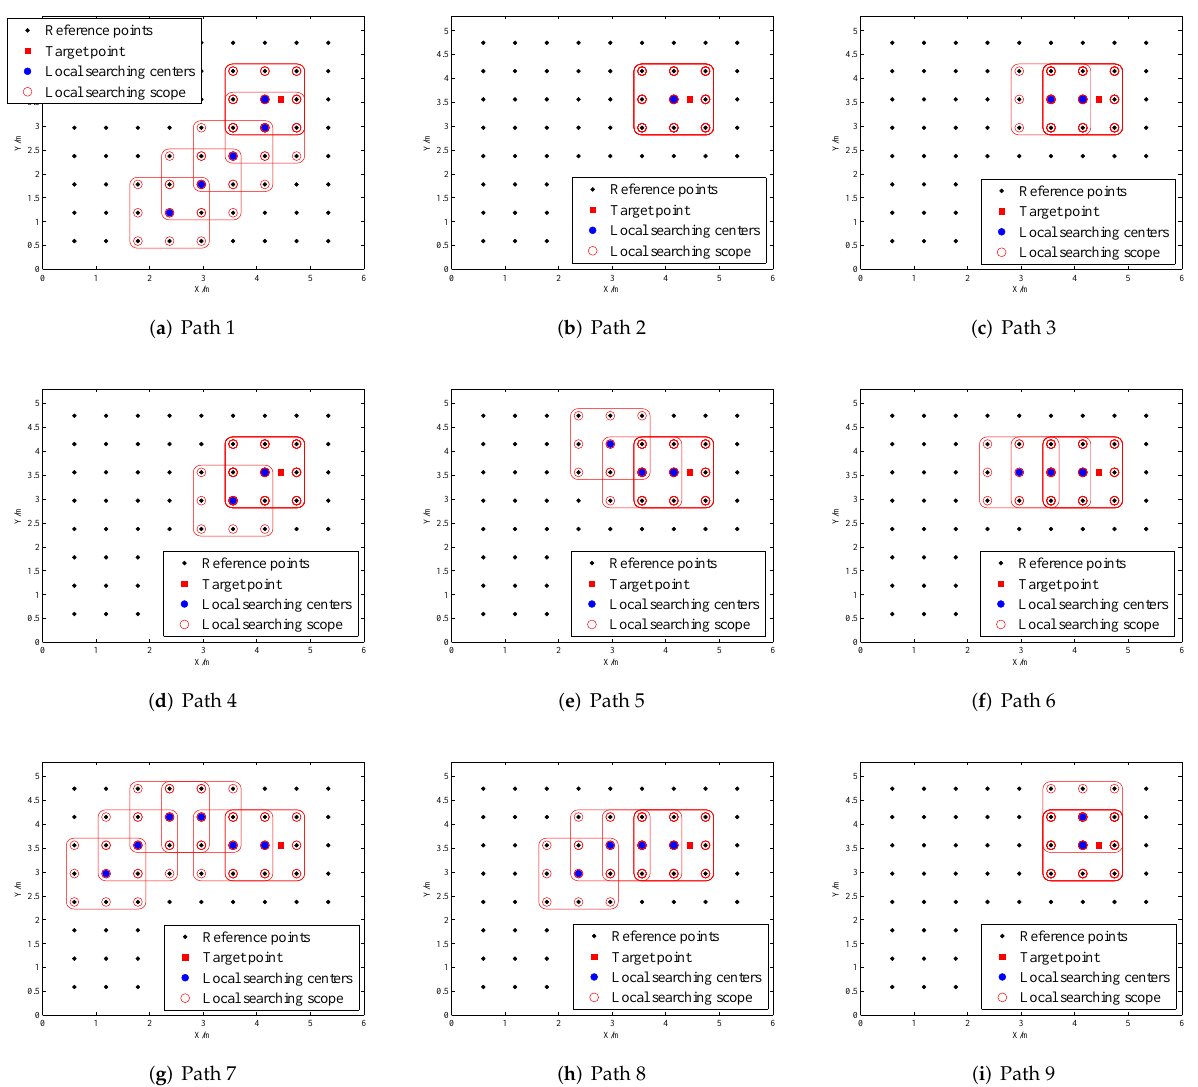
Figure 6. The search path of 10 independent tests for the ninth test point. All of the test points gained equally precise results as the traditional linear matching method in the experiments. What is more, as Figure 7 shows, RP numbers 54, 55, 60 and 62 are selected as the adjacent RPs of test point 9 by the traditional linear matching method, where RP 60 is the mismatched adjacent RP, which results in test point 9 gaining a positioning error of 0.1293 m at last, which is more than the position method based on the greedy RPs searching method. By which the adjacent RPs mismatch phenomenon is avoided, and the positioning error is improved to 0.0377